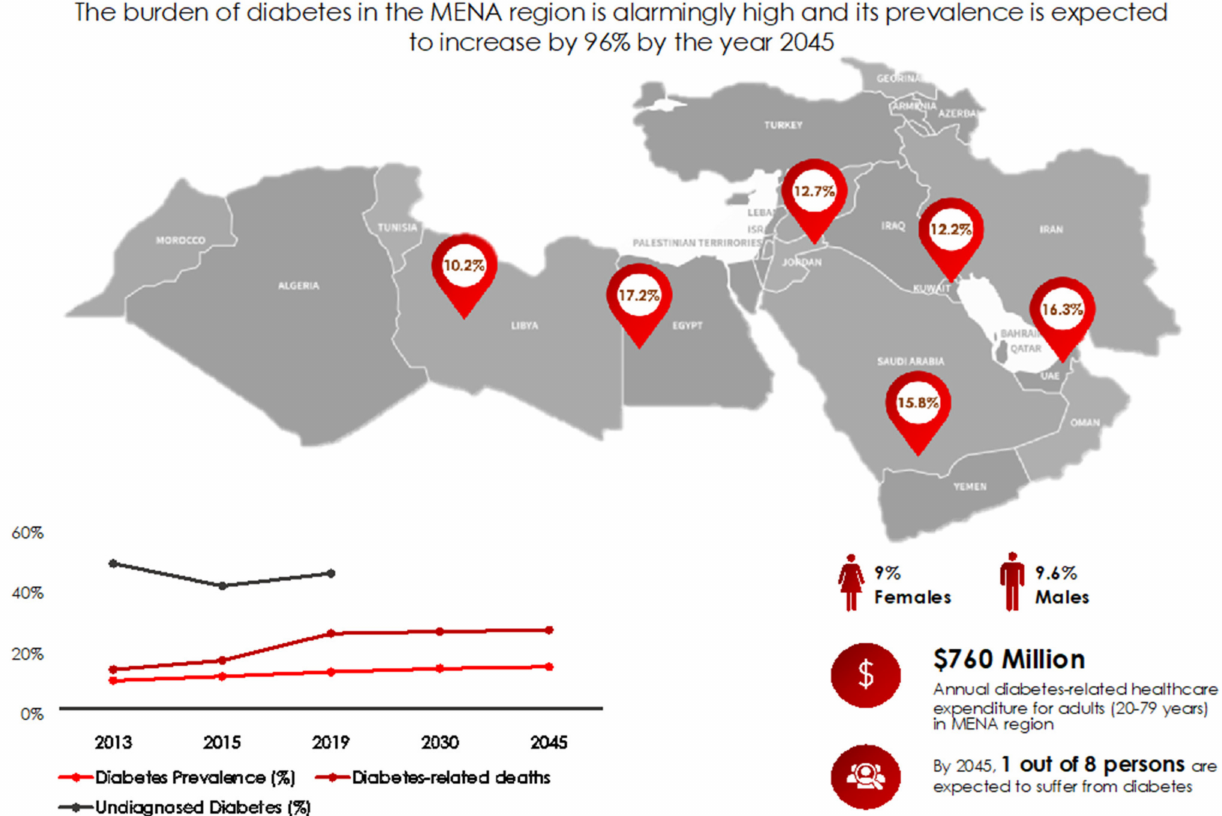
Figure 1. Diabetes prevalence in countries of the Middle Eastern and North African (MENA) region based on International Diabetes Federation (IDF) estimates 2019 [1]. MENA countries include Algeria, Bahrain, Egypt, Iran, Iraq, Jordan, Kuwait, Lebanon, Libya, Morocco, Oman, Qatar, Saudi Arabia, State of Palestine, Sudan, Syrian Arab Republic, Tunisia, United Arab Emirates, and